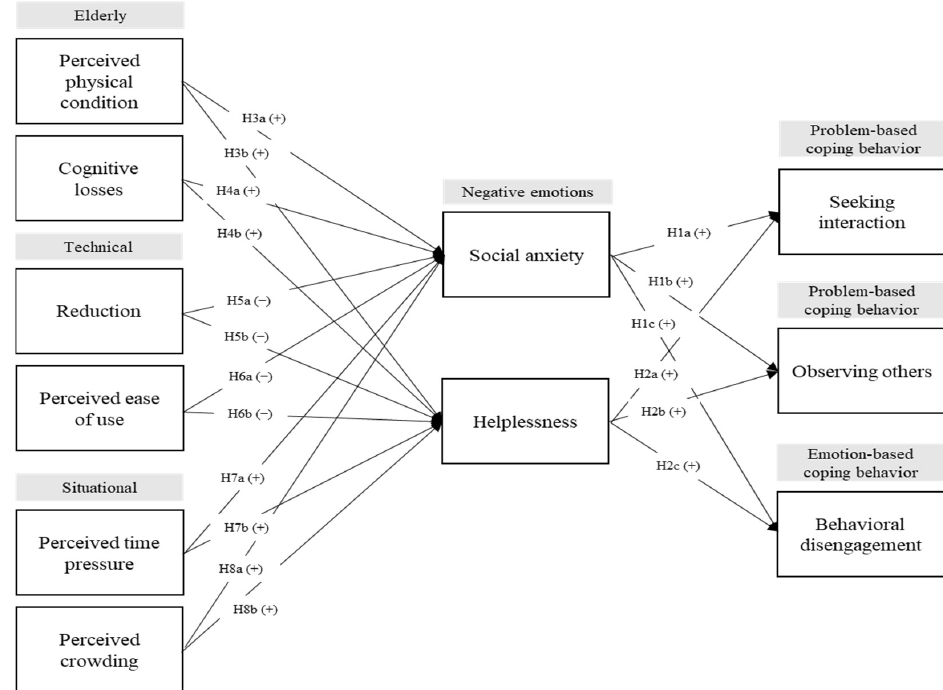
Figure 1. Research model.